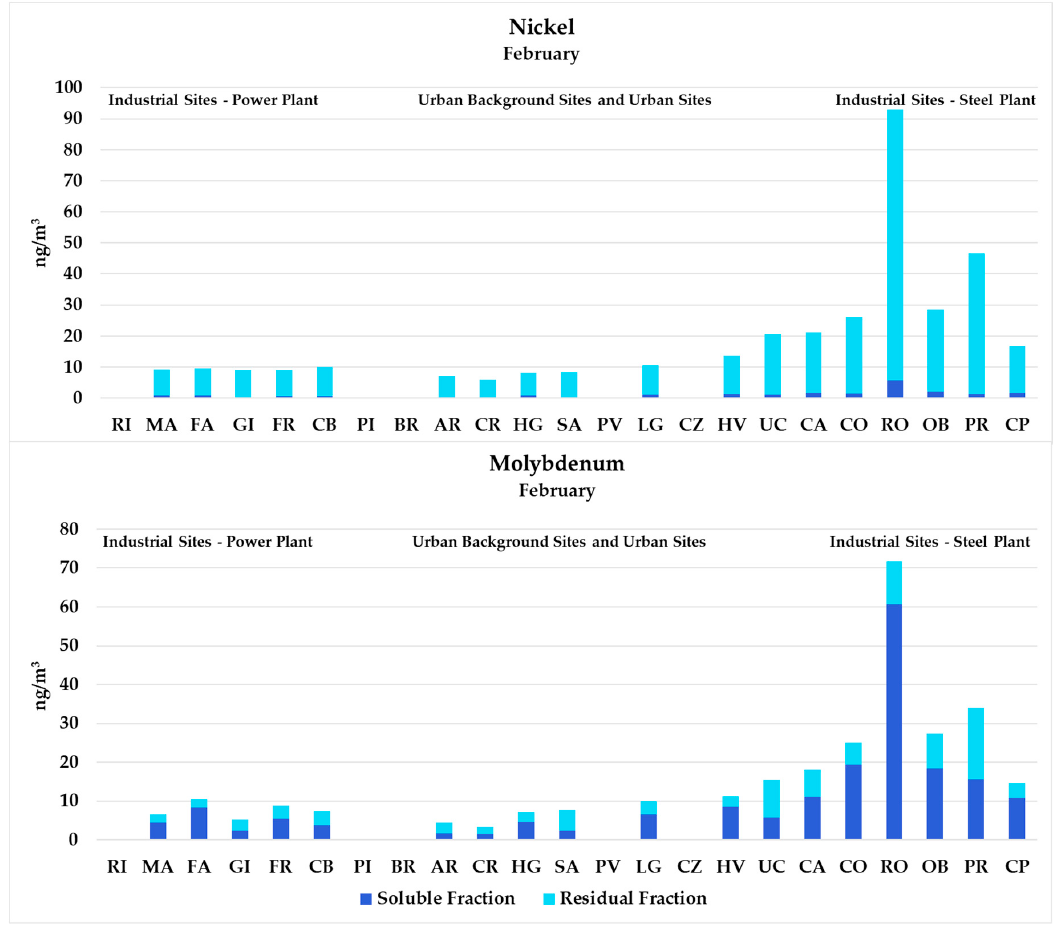
Figure 5. Soluble and residual fractions of Ni and Mo concentrations (ng/m 3 ) recorded in February at the 23 collection